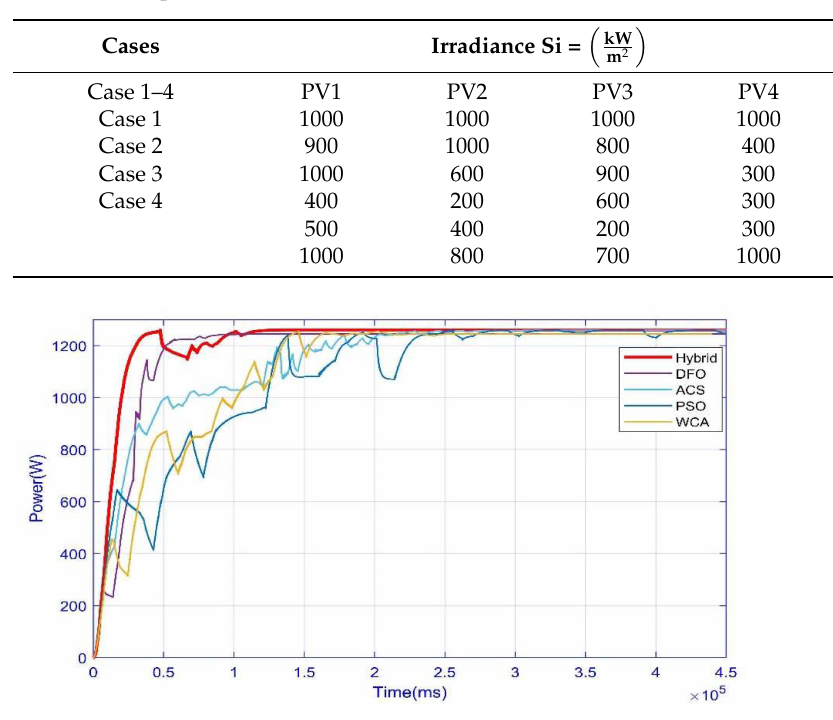
Table 2. Description of different cases.